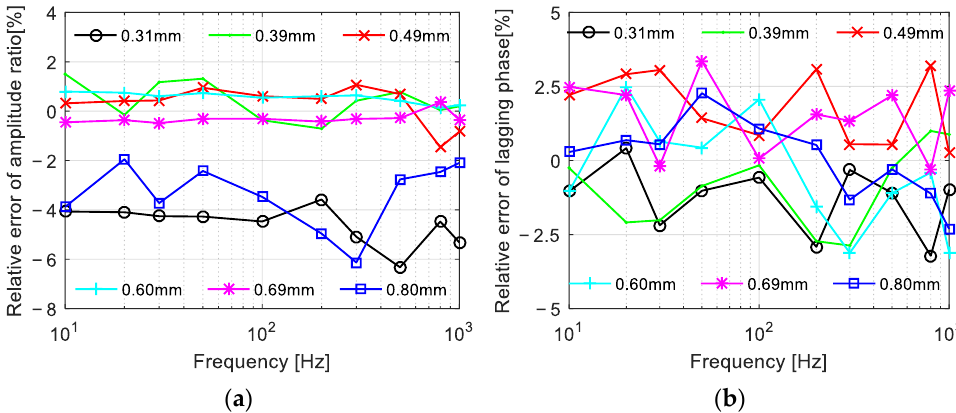
Figure 7. The relative errors of the model in computing the coil current under a harmonic voltage: ( a ) the relative errors of computing the amplitude ratio; ( b ) the relative errors of computing the phase lag.